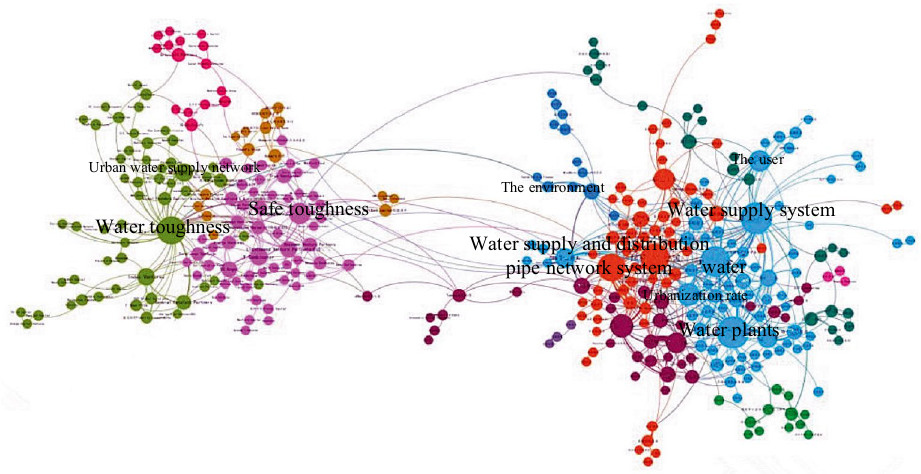
Figure 1. Visual analysis diagram of literature related to urban water supply systems (the figure shows a visual analysis of literature in the last 10 years, with foreign countries on the left and China on the